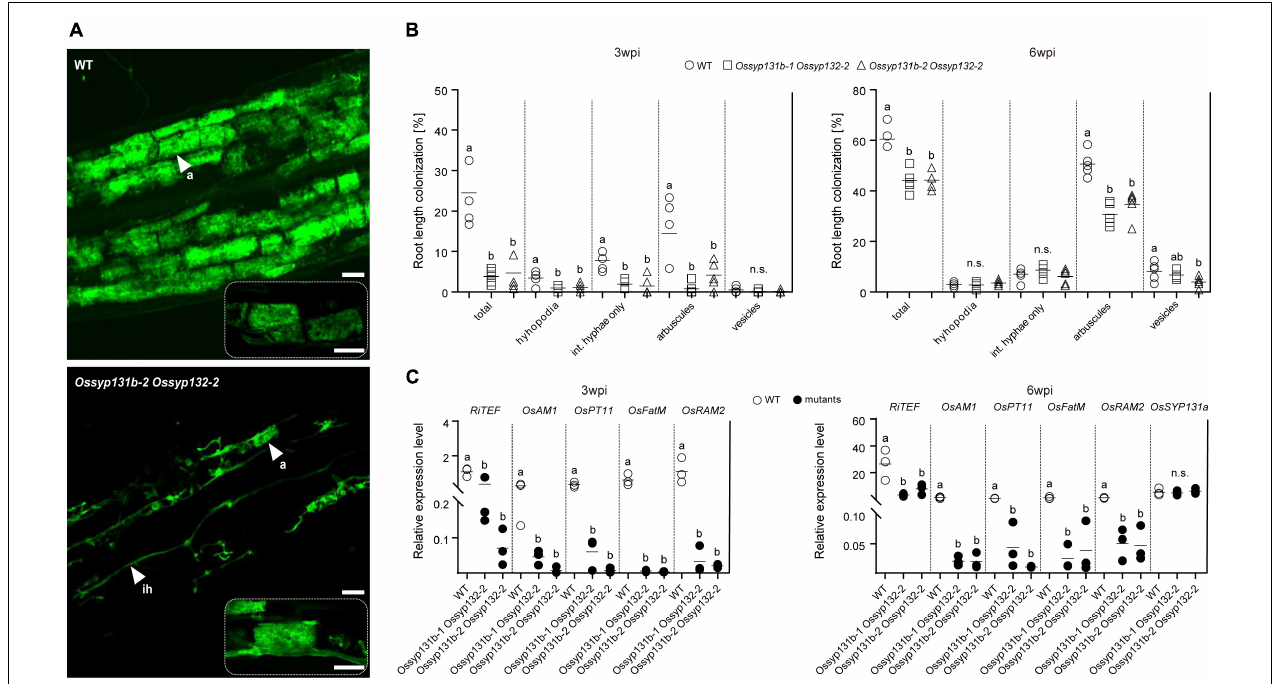
FIGURE 5 | AM fungal colonization was impaired in the Ossyp131b Ossyp132 double mutants. (A) Laser scanning confocal images showing fungal structures stained by WGA-Alexa Fluor 488 in WT rice roots and the Ossyp131b Ossyp132 double mutants colonized by R. irregularis at 6-wpi. White arrows indicate mycorrhizal structures: a, arbuscule; ih, intraradical hyphae. Scale bars = 20 µ m (above images), 50 µ m (below images), or 25 µ m (rectangle images with dotted lines). (B) The root length colonization rates (%) containing total, hyphopodia, intraradical hyphae, arbuscules, and vesicles of WT rice and the Ossyp131b Ossyp132 double mutants by R. irregularis at 3- and 6-wpi were determined by the gridline intersect method. Data were individual values from five biological replicates and the horizontal line showed the mean value. Different letters indicate significant statistical differences between genotypes evaluated by the Tukey’s honest significance test (between the pairs, P < 0.05 or P > 0.05, n.s., no significance). Int. hyphae, intraradical hyphae. (C) The transcript accumulation of AM marker genes RiTEF , OsAM1 , OsPT11 , OsFatM ( fat required for AM symbiosis ) and OsRAM2 ( required for arbuscular mycorrhization2 ) as well as OsSYP131a were measured by qRT-PCR in the WT roots and Ossyp131b Ossyp132 double mutants by R. irregularis . The housekeeping gene, OsUBI1 , was used for normalization. Data are individual values from three biological replicates and the horizontal line shows the mean value. Different letters indicate levels of statistical differences evaluated by the Tukey’s test, too (all pairs except the OsSYP131a gene, P < 0.05). This is a representative experiment that was repeated three times with similar